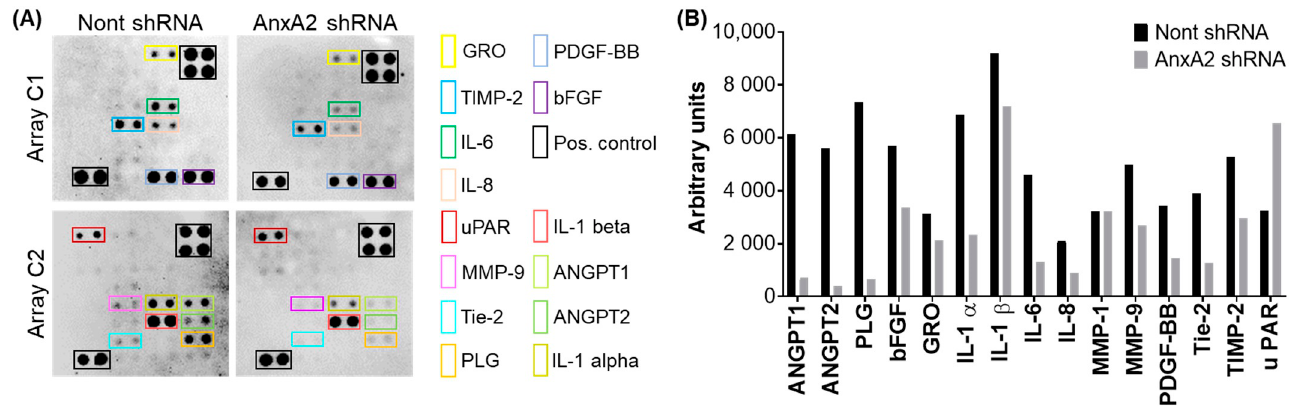
Figure 7. The differential expression of angiogenic growth factors and cytokines in T24 cells expressing non-targeting shRNA or AnxA2 shRNA. ( A ) The human angiogenesis antibody array membrane, onto which 43 angiogenic proteins are blotted in duplicates, was incubated with cell lysates of T24 cells expressing non-targeting shRNA or AnxA2 shRNA. The proteins showing expression in T24 cells were highlighted in rectangles. ( B ) Arrays were analyzed using densitometry and normalized to the internal control. The densitometric arbitrary units indicate the increase or decrease of the intensity of proteins in AnxA2-depleted T24 cells compared to control cells. Uncropped Western Blot of (A) is available in Figure S1.